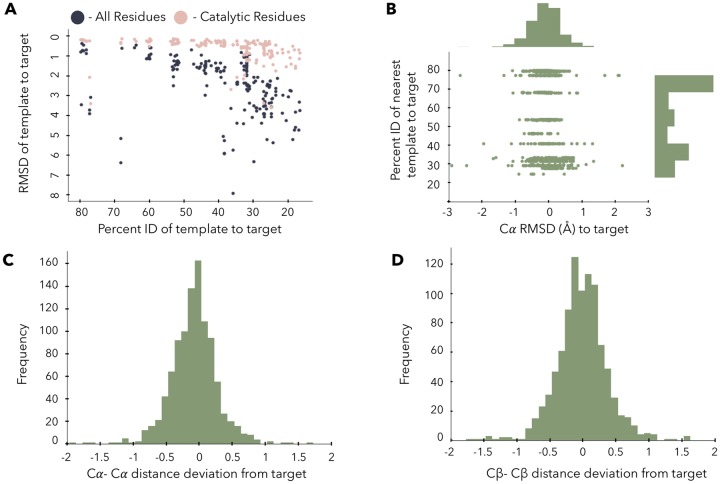
Structural informatics of conservation of inter-catalytic residue atom distances A- The RMSD of each target to each template structure is shown. The RMSD over just the catalytic residues (light pink), and the overall protein RMSD values are shown as a function of the sequence homology of each template. B—Distribution of the benchmark template percent identity to target sequences and the deviation of the Cα of each template to the target catalytic residues. C- Deviation of Cα—Cα distances to the reference distances in the target crystal structure. Note the gaussian shape with a 0.5Å deviation. D- The Cβ—Cβ deviation to reference measurements, again with a narrow distribution. The distance deviation distribution of Cα-Cβ are similar to that of Cβ-Cβ and are centered at 0 with an approximate deviation of 0.5Å (S1 Fig).